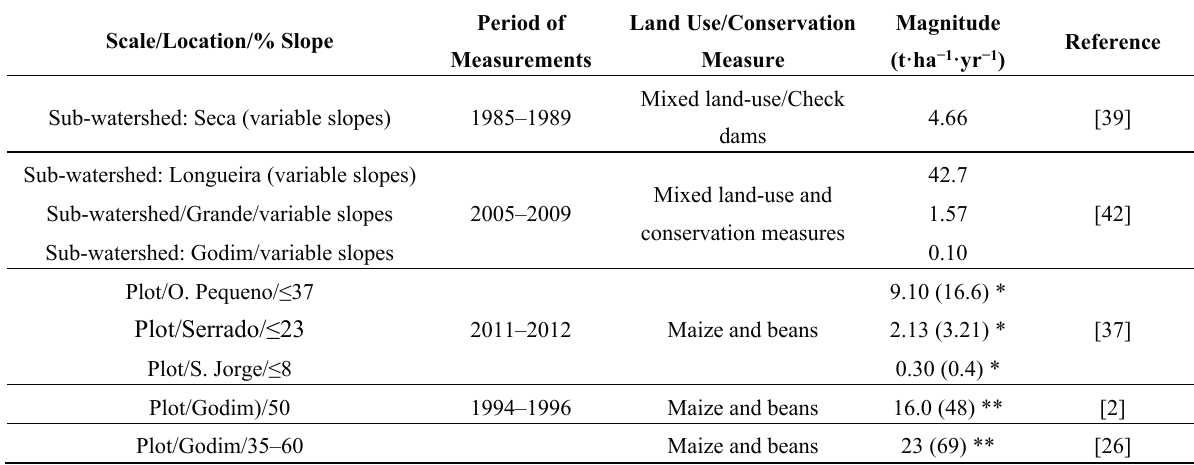
Table 1. Mean rates of soil erosion in the Ribeira Seca Watershed at different scales and